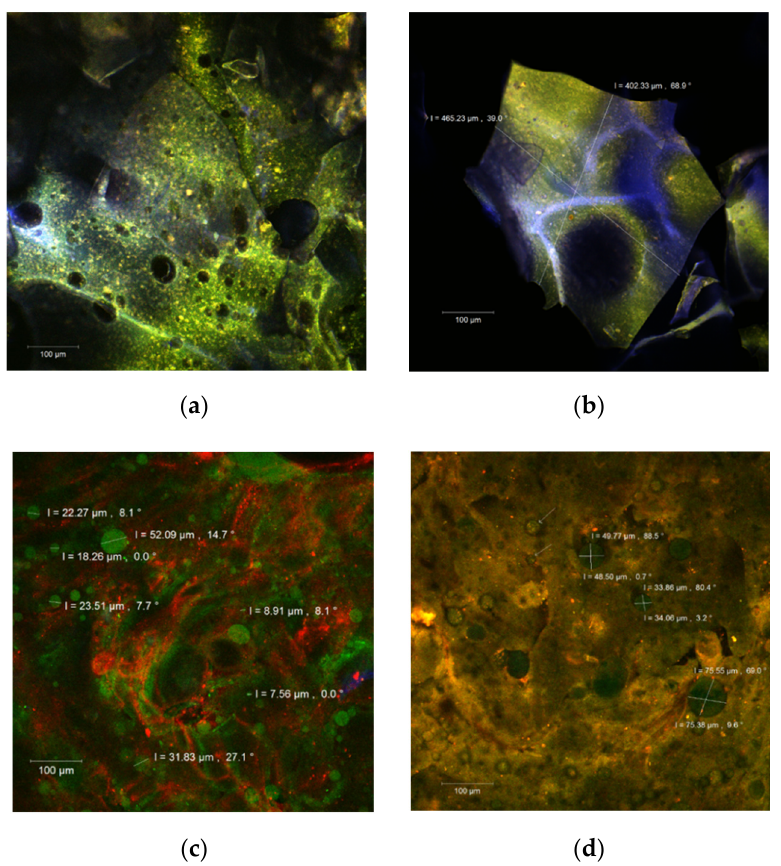
Figure 1. The confocal laser scanning microscopy (CLSM) images of the native, unstained ( a,b ), and fluorophore dyed powders ( c,d ).